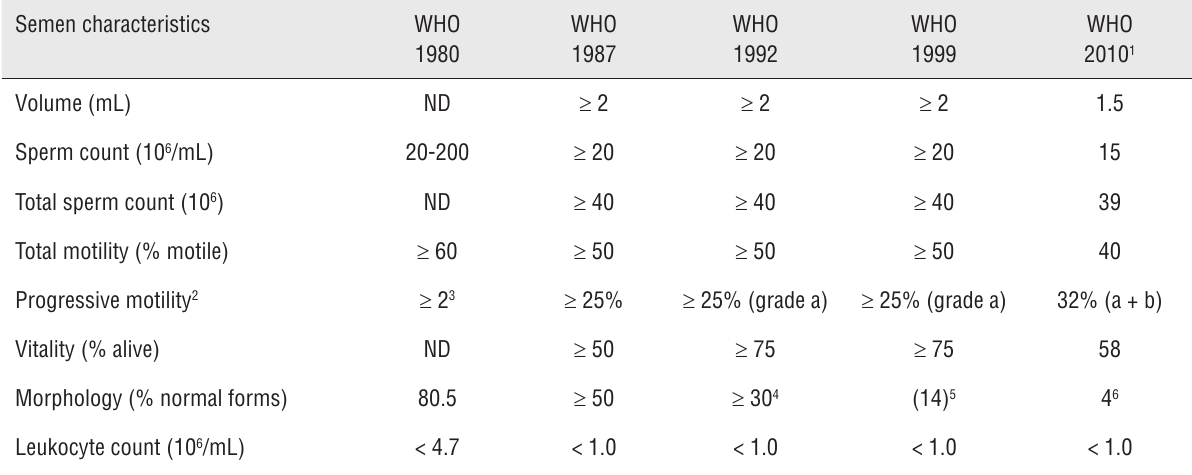
Table 1 - Cut-off reference values for semen characteristics as published in consecutive WHO manuals. Semen